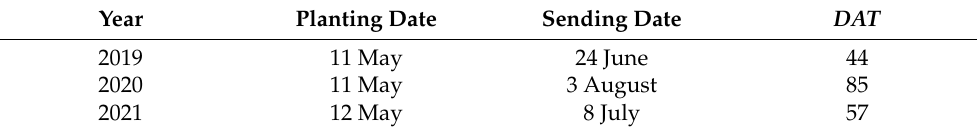
Table 5. Summary of planting, sensing dates, and the days of GDD > 0 in 2019–2021.